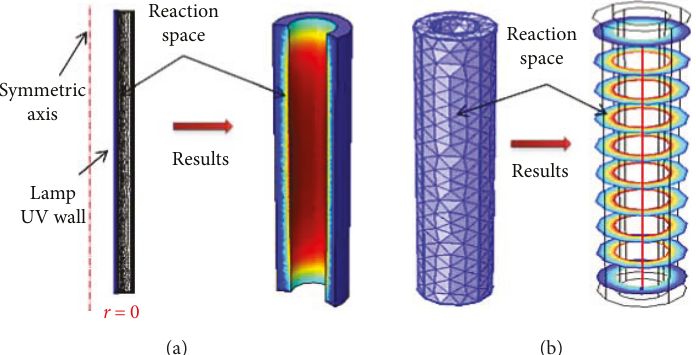
Figure 4: Graphical representation of photocatalytic reactor and geometry employed to solve (a) four- fl ux model and (b) discrete ordinate method, in COMSOL Multiphysics.